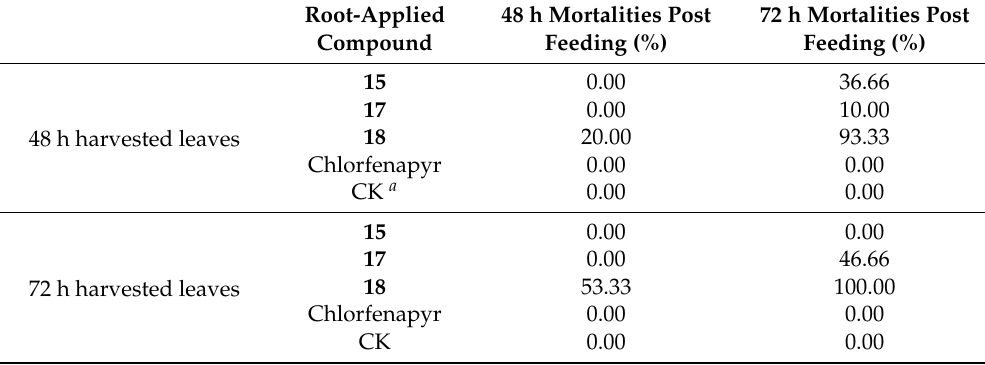
Table 5. The systemicinsecticidal activity of the conjugates against P. xylostella . Root-Applied Compound Feeding